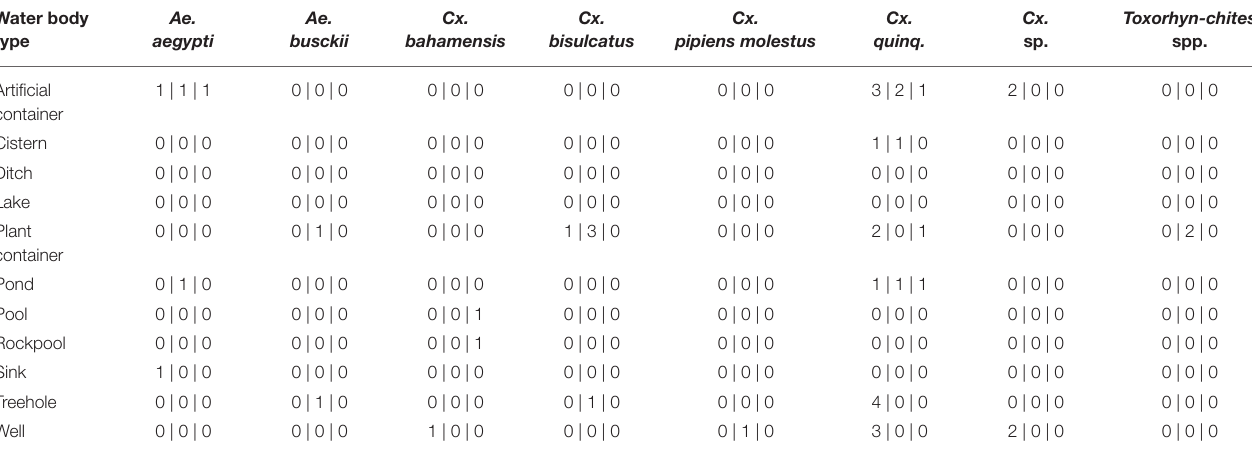
TABLE 2 | Species composition per water body type for all three